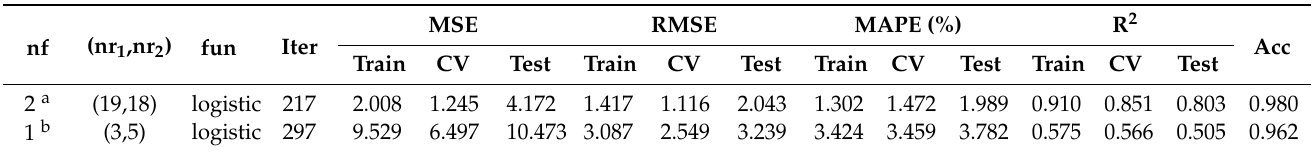
Figure 8. Relationship between two thermal indicators and water content of rice during the three growth stages; tillering (1st stage), stem elongation (2nd stage), and panicle initiation (3rd stage): ( a ) CWSI-based CWC, and ( b ) NRCT-based CWC. Table 6. Various architectures of BPNN model based on thermal features with MSE, RMSE, MAPE (%), Acc, and R 2 in training, cross-validation, and test